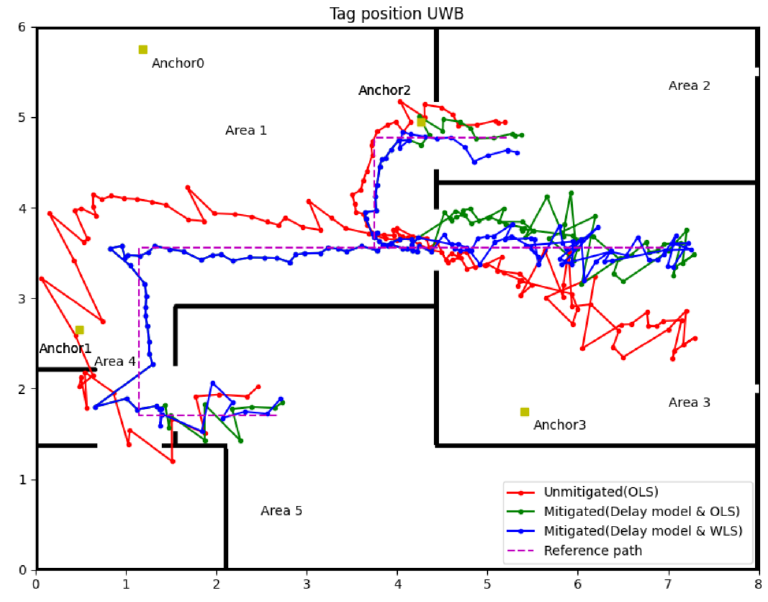
Figure 12. Experiment 2 results for the delay model with WLS.